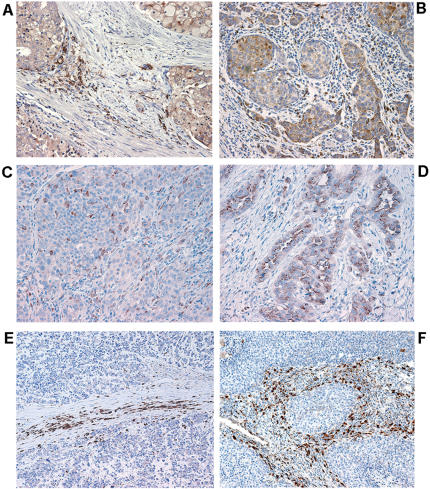
Histological pattern of cathepsin D expression in human cancers.Representative images of cathepsin D expression in human cancer samples.(A) prostate (B) breast cancer showing cathepsin D expression (brown) by tumor and stromal cells; (C) large-cell lung carcinoma and (D) lung adenocarcinoma showing cathepsin D expression by tumor cells and to a lesser extent by stromal cells; (E, F), cathepsin D is almost exclusively expressed by stromal cells in small-cell lung carcinomas (E) and large-cell neuroendocrine carcinomas (F), whereas tumor cells are almost devoid of cathepin D expression.Nuclei were counterstained with haematoxylin.Magnification 200×.